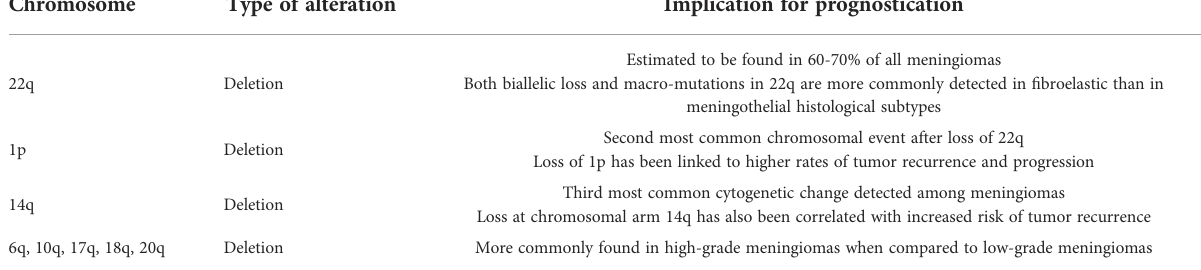
TABLE 3 Commonly identi fi ed cytogenetic alterations in meningiomas.